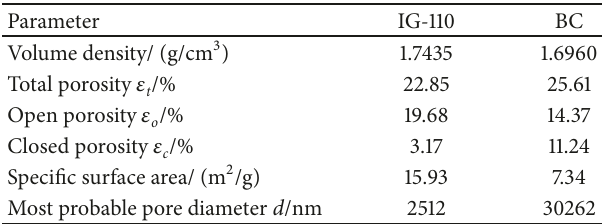
Table 2: Pore parameters of carbon materials.